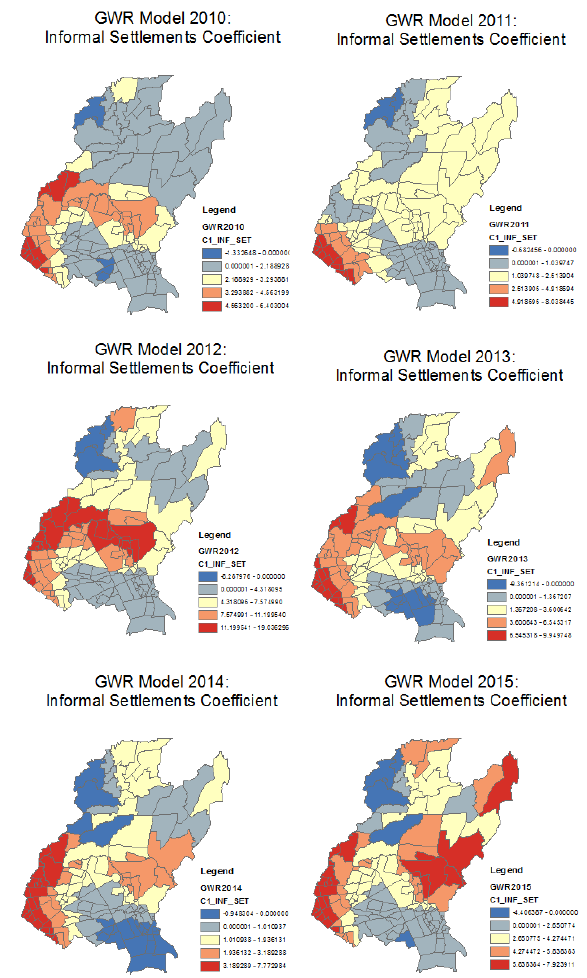
Figure 7. Map of the coefficients of informal settlements as predictor for each GWR model from 2010 to 2015.